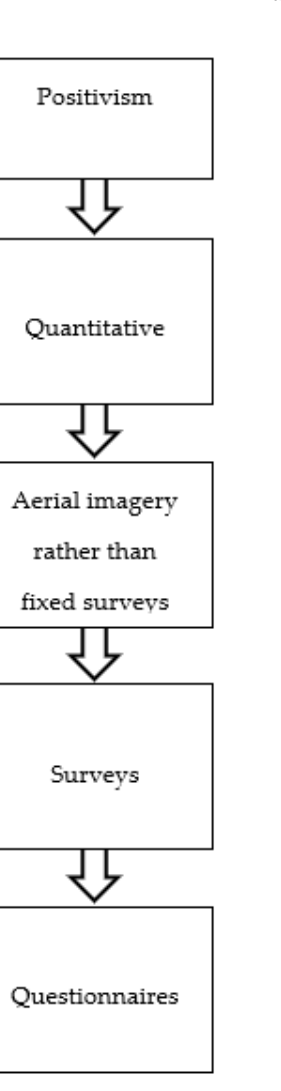
Figure 1. Paradigm, Methodologies and Methods Used for the